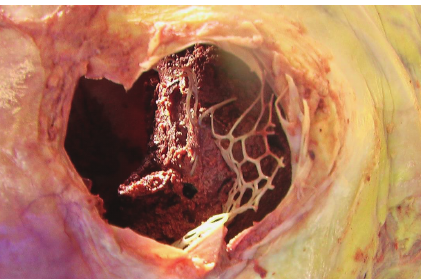
Figure 1: Large thrombus in the center of the Chiari network within the right atrium of the heart.